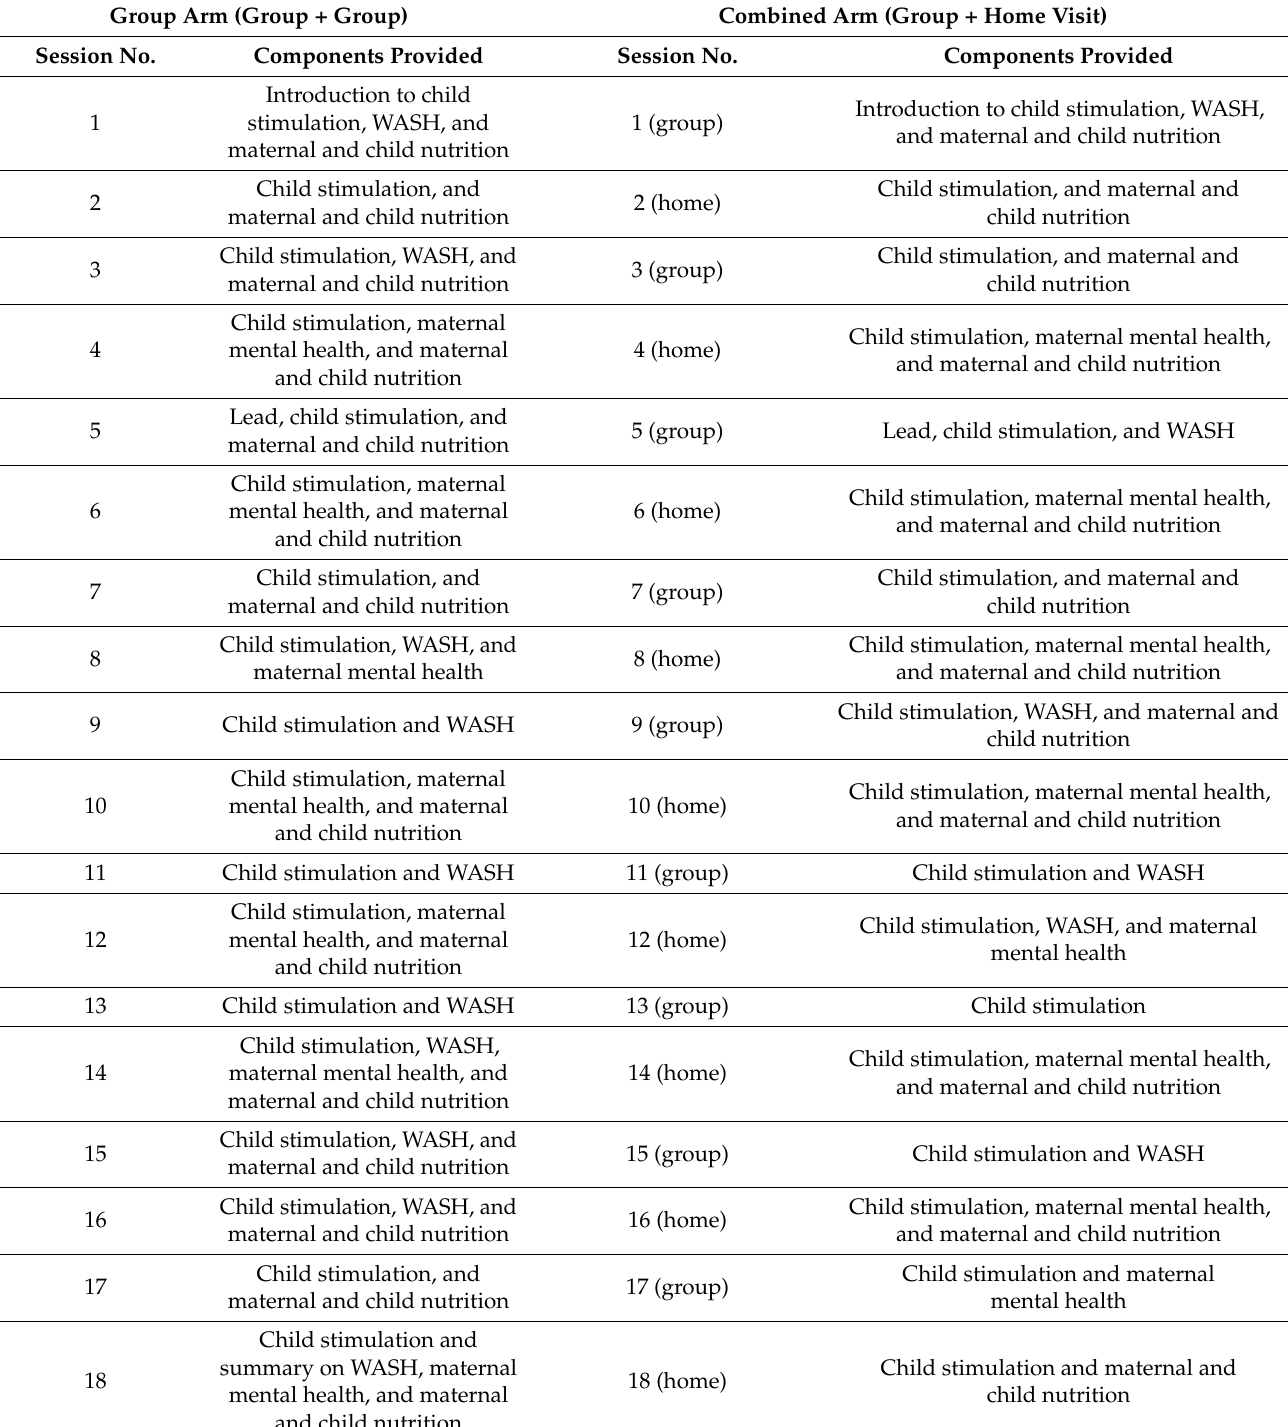
Table 1. Session content delivered by CHWs through group and combined arm. Group Arm (Group + Group) Session